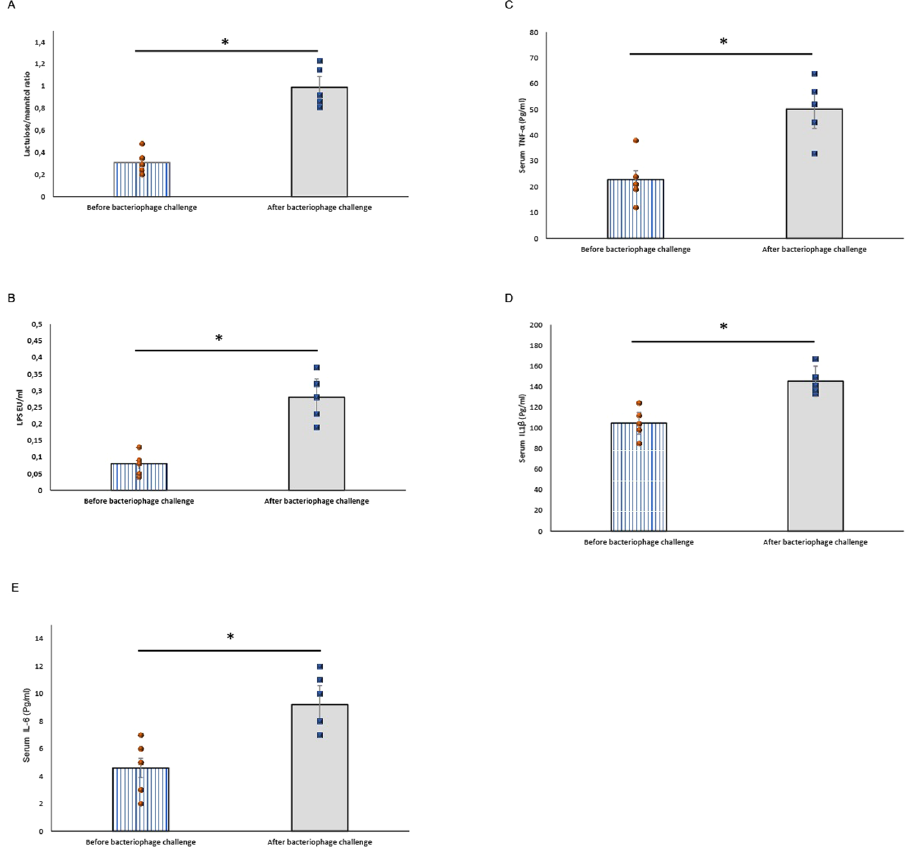
Figure 1. Effects of bacteriophages on intestinal permeability and endotoxemia. Albino Wistar male rats (n = 5) were challenged with a bacteriophage cocktail for 10 days. Each animal was used as its own baseline control. Blood and urine samples were collected from all rats at the same time and subjected to various analytical tests as described in the Materials and Methods section. ( A ) Intestinal permeability expressed as the lactulose/mannitol ratio. Treatment with bacteriophages resulted in a significant alteration of intestinal permeability (p < 0.05). ( B ) Parameters of endotoxemia. Administration of bacteriophages increased the serum LPS levels (p < 0.05). ( C–E ) Serum levels of inflammation-related cytokines: ( C ) TNF- α , ( D ) IL-1 β , and ( E ) IL-6. Data are expressed as the means ± standard error of the mean (SEM). The non-parametric paired Wilcoxon signed-rank test was applied to the analysis of pre- and post-challenge